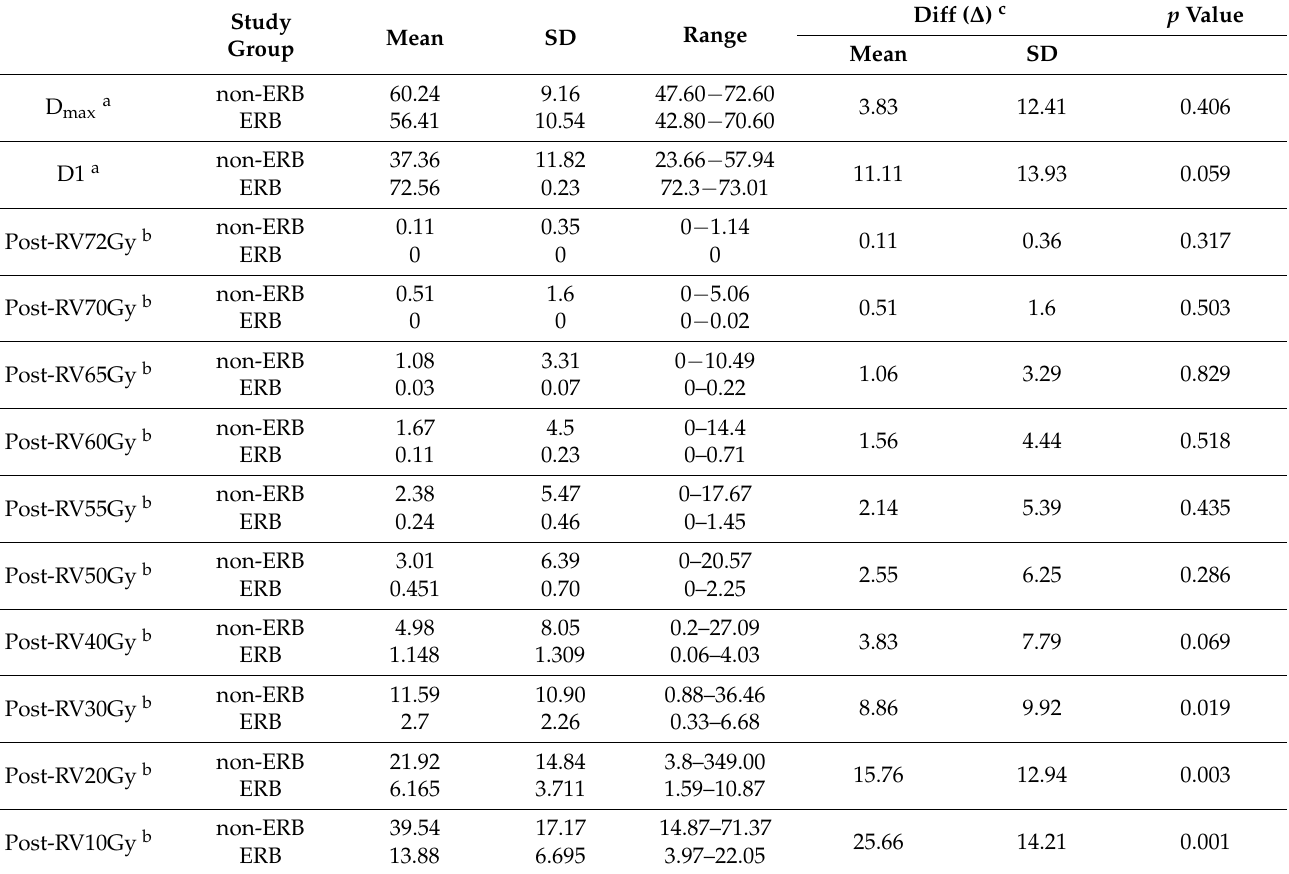
Table 3. DVH analysis for the posterior rectum comparing between the non-ERB plans and ERB plans.